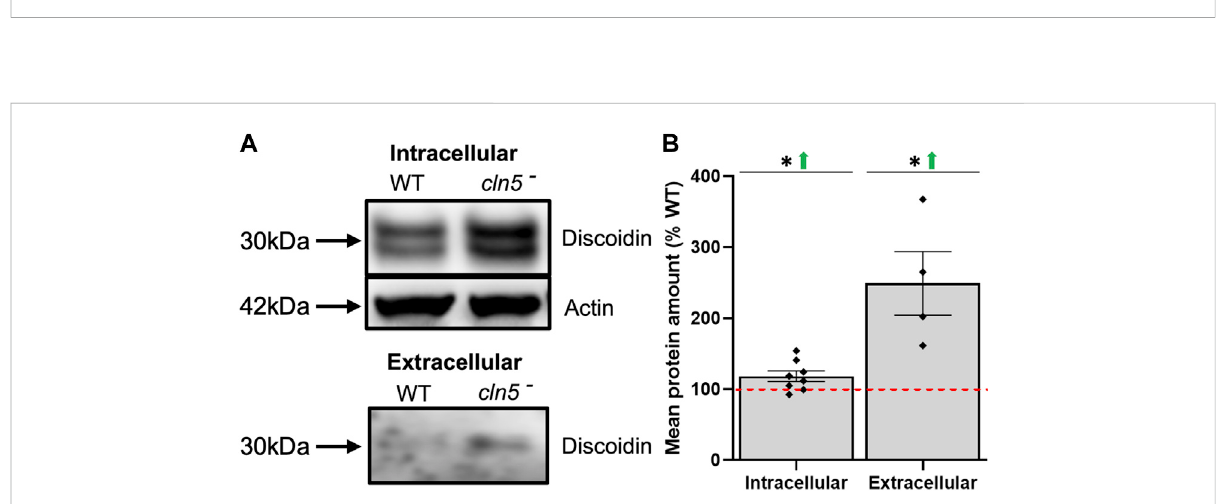
FIGURE 5 Lossof cln5 affectstheintracellularandextracellularamountsofdiscoidinduringstarvation. (A) Wholecell(WC)lysates(30-50 µg)andclari fi ed conditioned buffer (CB) (0.15 – 0.375 µg) were collected from WT and cln5 -cells starved for 4 h. Equal protein amounts were subjected to SDS- PAGE/western blotting, and membranes were probed with anti-Dsc and anti- β -actin (loading control). (B) Protein bands were quanti fi ed using Fiji/ ImageJ and the intracellular values for discoidin were standardized against the levels of β -actin. Data presented as mean protein amount (% WT) ± SEM ( n ≥ 4). * p < 0.05 (one sample t -test). NS – not signi fi